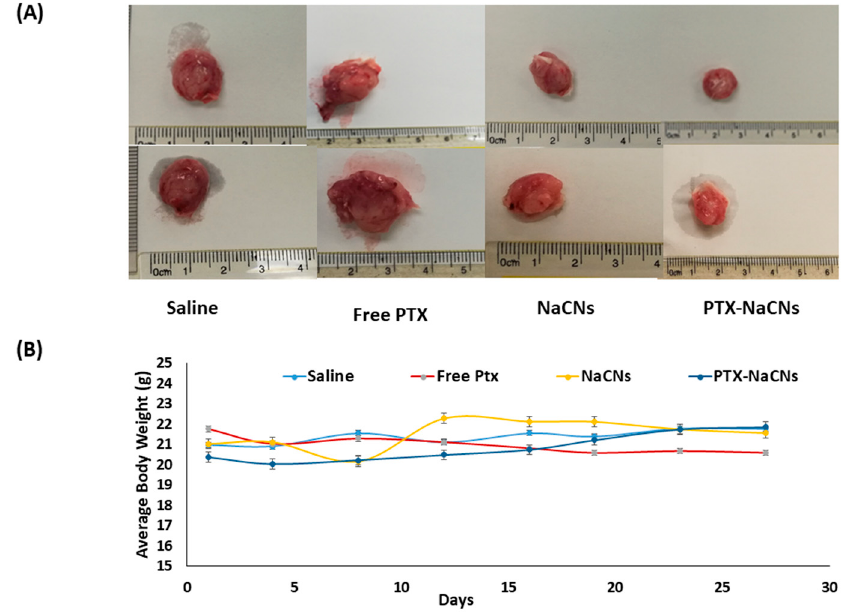
Figure 16. ( A ) Excised tumor images illustrating the different anti-tumor efficacy between the groups. ( B ) Mean body weight curves of tumor-induced mice treated with NaCNs and PTX-NaCNs compared with the free PTX and saline-treated groups over the treatment period of 28 days.